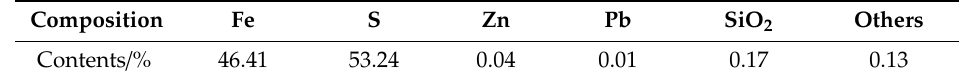
Figure 2. Particle size distribution of pyrite. Table 1. Chemical composition of pure minerals.